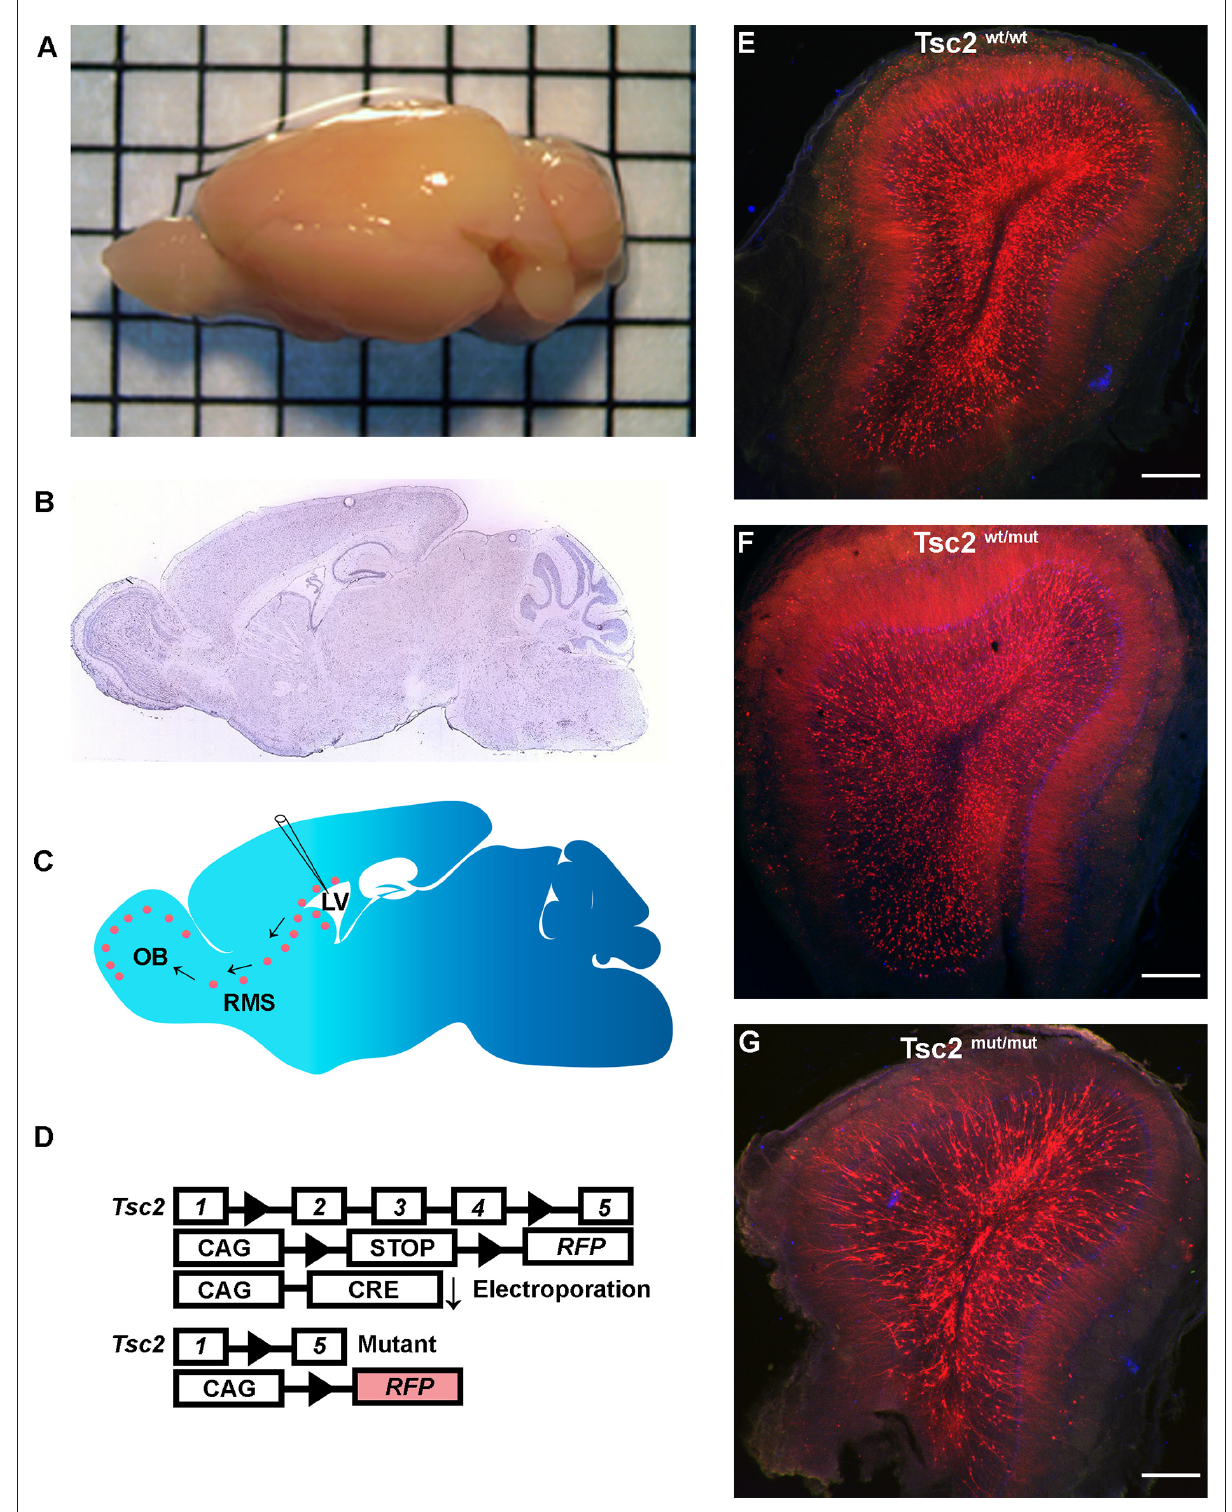
FIGURE2 Electroporation models somatic Tsc2 mutation. (A) Image of mouse brain demonstrating an electroporated brain. (B) Sagittal section of mouse brain (Allen Brain Institute). (C) Schematic of electroporation demonstrating labeling of NSCs, neuroblasts, and GCs. (D) Schematic diagram of conditional Tsc2 alleles and inducible RFP before and after electroporation of CRE recombination. (E–G) 5x images of coronal sections of